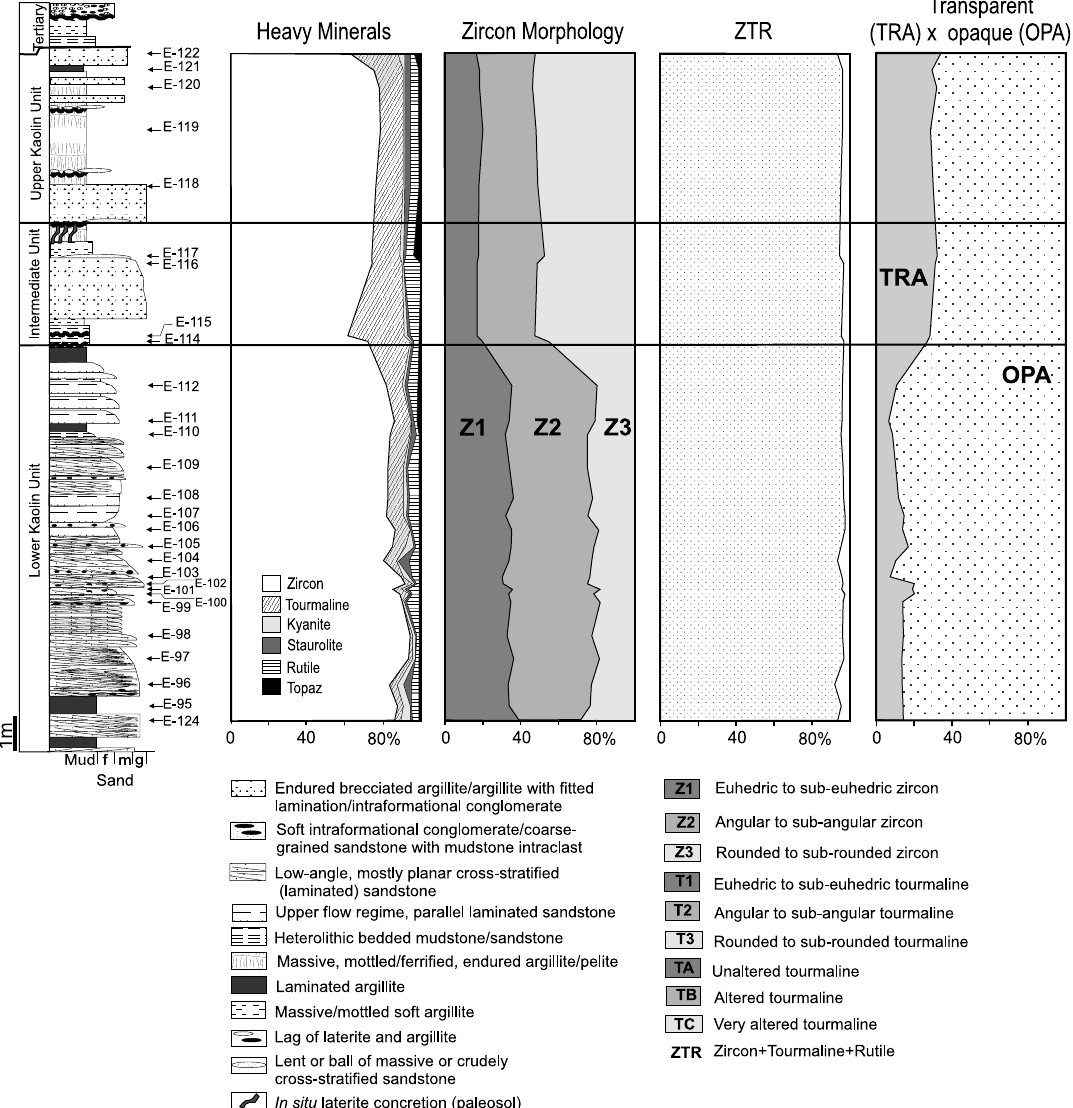
Fig. 3 – Measured lithostratigraphic profile 1 of the IRCC quarry, with frequencies of main heavy minerals and of their